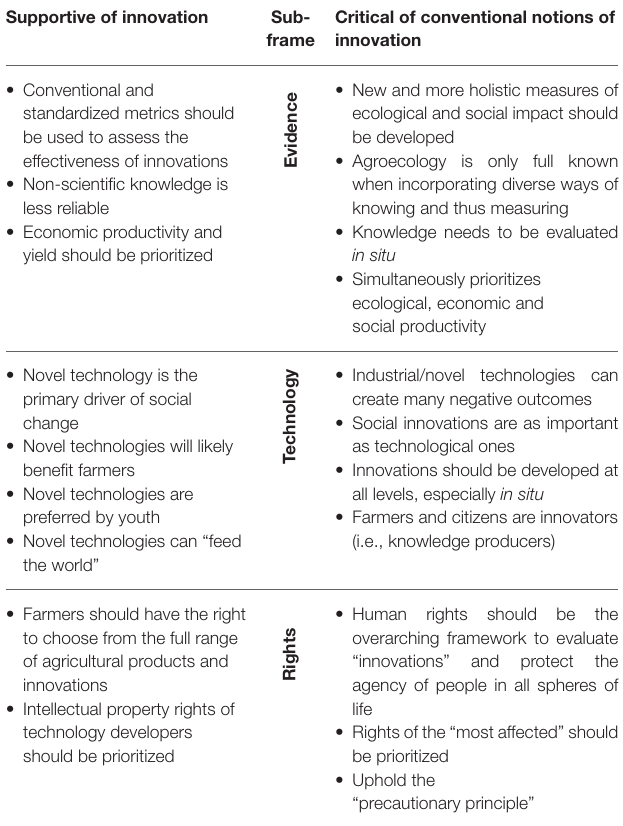
TABLE 1 | Original codes and how they were grouped under final three